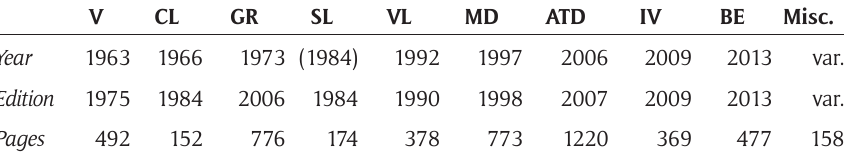
Table 1: Publication years, editions I worked with, and total numbers of pages and words for each